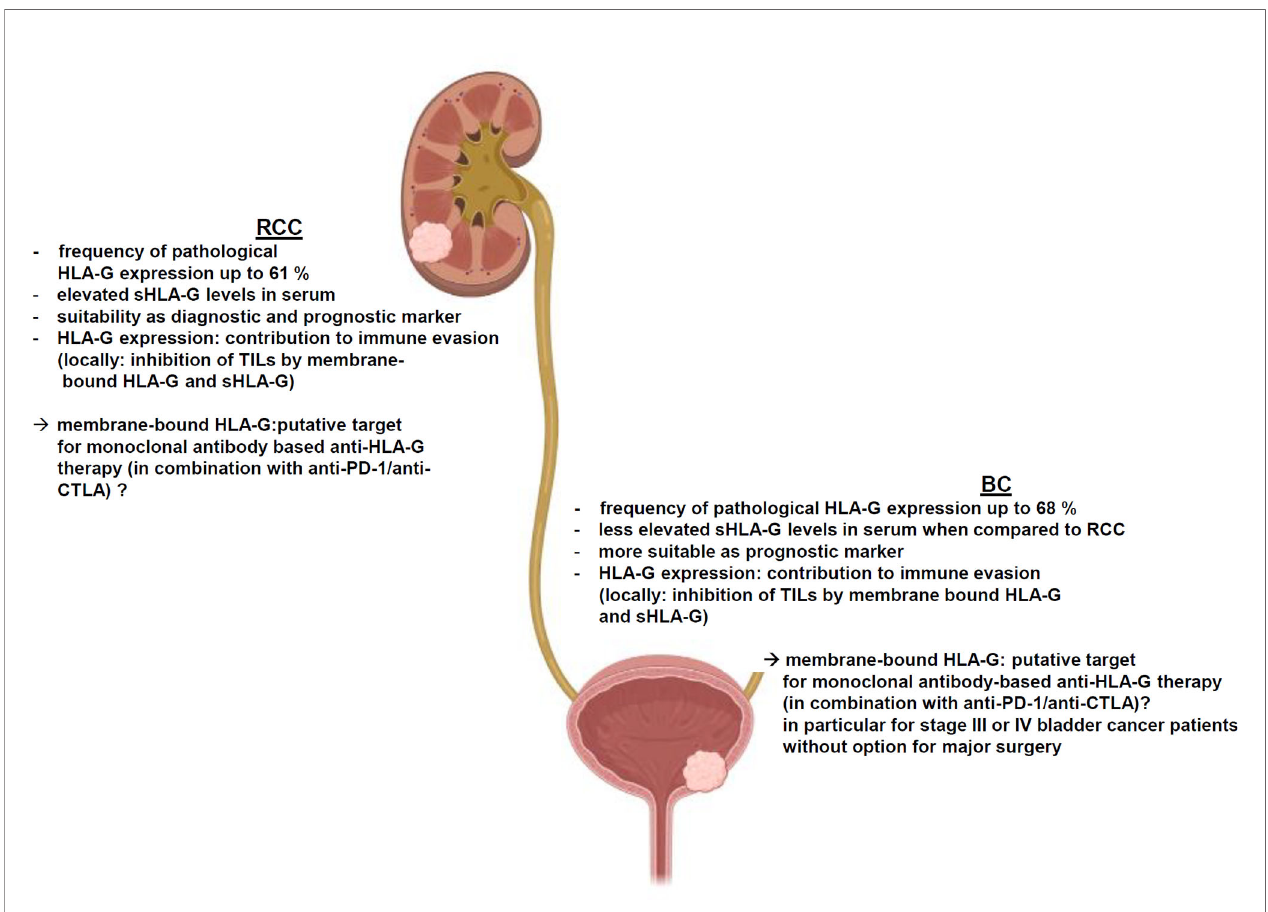
FIGURE 2 | HLA-G-mediated immune escape of RCC and bladder cancer and its clinical